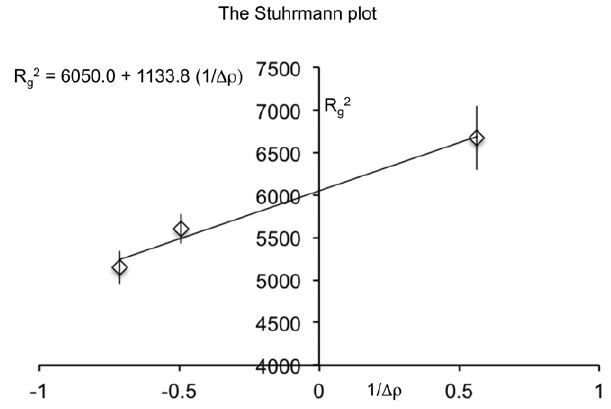
Figure 3. The Stuhrmann plot (R g2 versus Dr 2 1 , Dr in 10 10 cm 2 2 , R g in A˚) obtained from the SANS dataset of the tbParB-D120 assembly. The real space radii of gyration derived from the corresponding pair distribution functions were used for the calculation of Stuhrmann plot. A straight-line fitted to the data (R 2 =0.98) is shown in black.